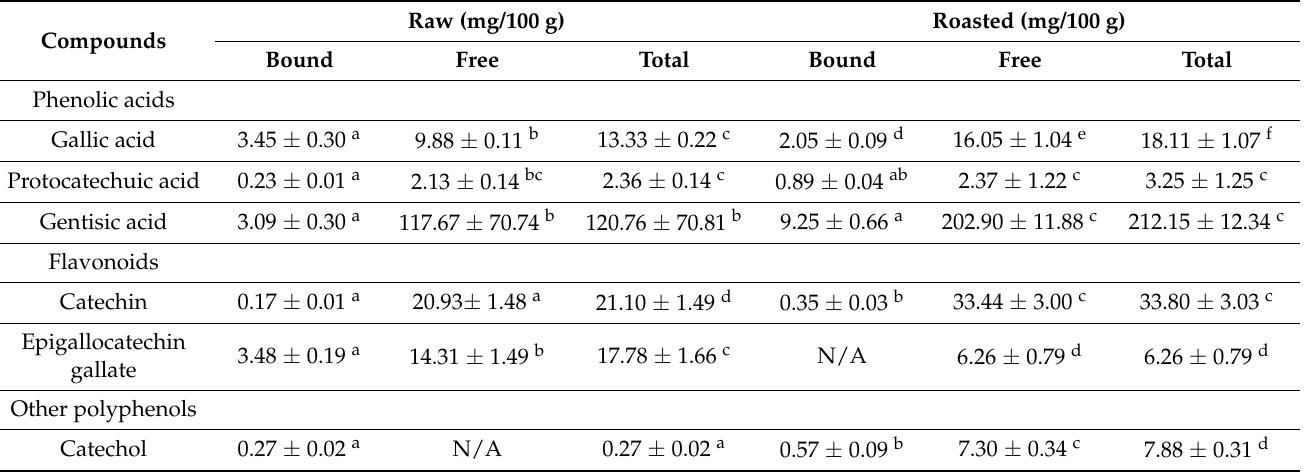
Table 2. Phenolic profiles of pistachios (raw and